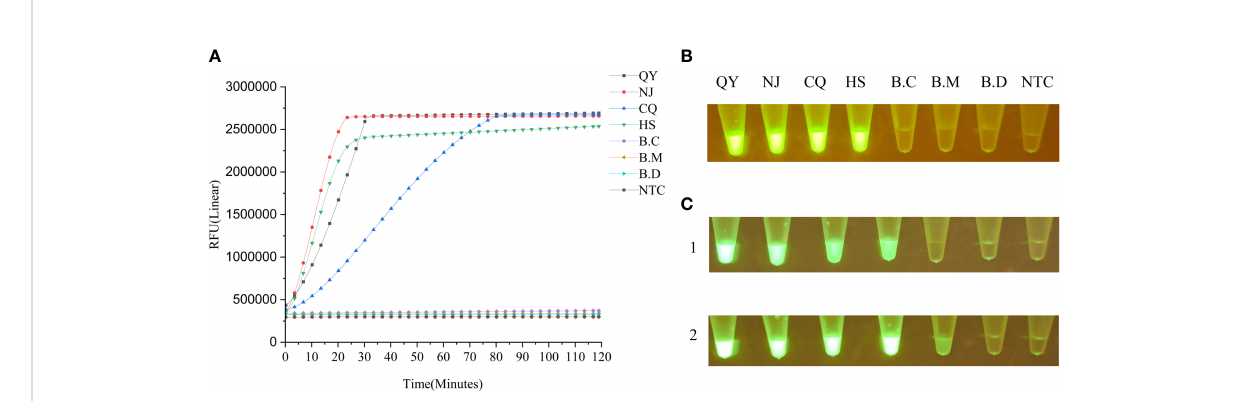
FIGURE 4 (A) Speci fi city of the LAMP-CRISPR/Cas12a assay evaluated by its ability to distinguish B xylophilus strains and related species. B.C: Botrytis cinerea ; B.M: B mucronatus ; QY: B xylophilus (from Liaoning); NJ: B xylophilus (from Nanjing); CQ: B xylophilus (from Chongqing); HS: B xylophilus (from Anhui); B.D: B doui ; NTC: negative control (ddH2O). (B) End-point fl uorescence visualization of the speci fi city test. (C) Detection of base changes or deletions in target sequences by LAMP-CRISPR/Cas12a assay by measuring fl uorescence intensity under blue- light irradiation 1 h after the reaction. Panel 1: From left to right, 0 – 5 base changes; the last tube is the negative control. At four base changes, the fl uorescence intensity dropped signi fi cantly. Panel 2: From left to right, 0 – 5 base deletions. the last tube is the negative control. At fi ve base deletions, the fl uorescence intensity dropped signi fi